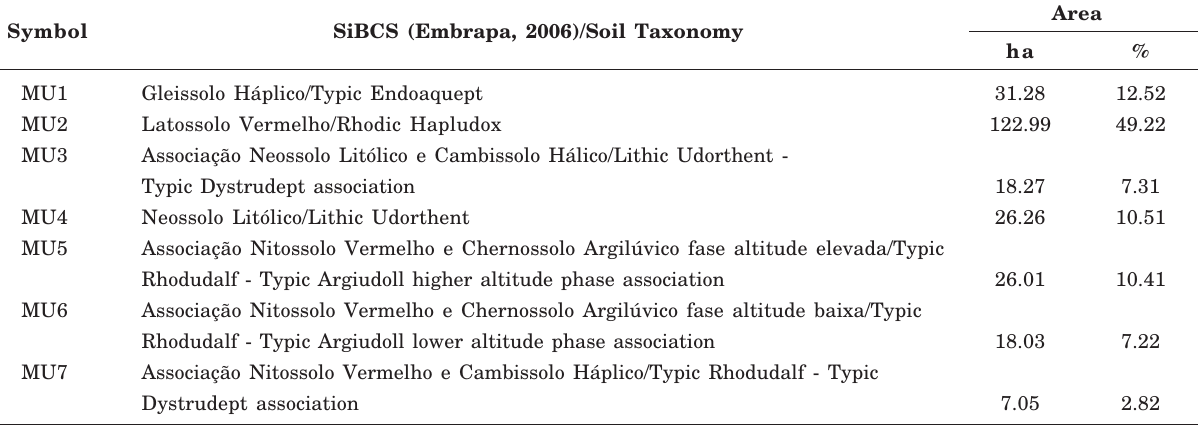
Table 1. Soil Mapping Units (MU) surveyed in the study area of the municipality of Erechim